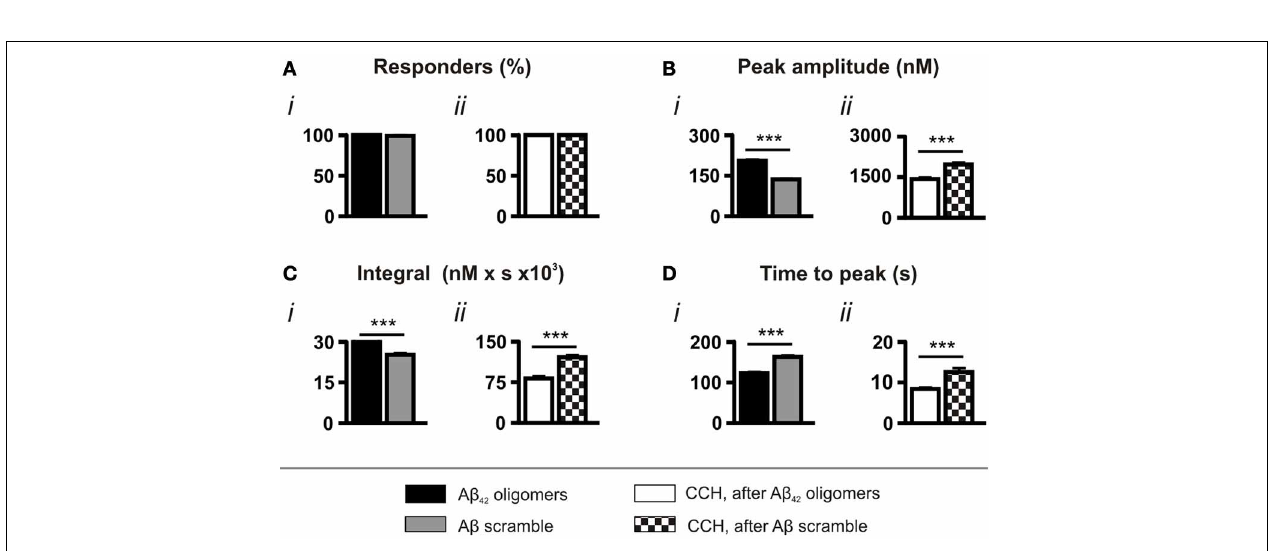
FIGURE 2 | A β 42 oligomer-induced Ca 2 + transients are sequence specific. Bar charts illustrating the magnitude of Ca 2 + responses elicited by SH-SY5Y cells following the application of 5 μ M A β 42 oligomers or A β scramble and 100 μ M CCH ( n > 370 cells). Data